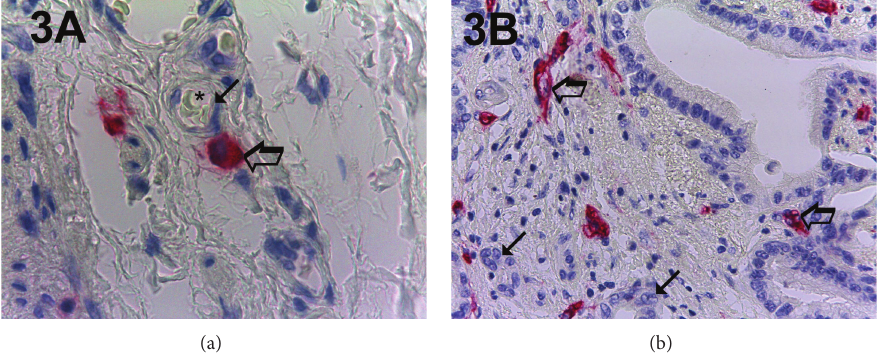
Figure 3: In (a) pancreatic ductal adenocarcinoma sample stained with the anti-tryptase antibody. Big arrow indicates a single red MC and small arrow indicates a microvessel with its lumen. The lumen is marked with an asterisk and there are well visible intraluminal red blood cells. In (b) a highly vascularized pancreatic ductal adenocarcinoma sample stained with the anti-CD-31 antibody. Big arrows indicate single red microvessels with their own lumen and small arrows indicate the bleu nucleus of cancer cells. Magnification: (a-b), × 1000 in